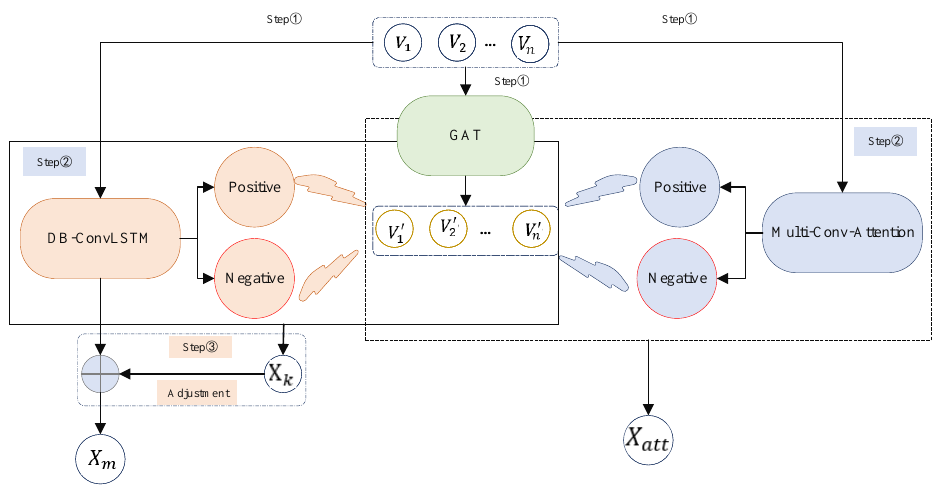
Figure 2. Step of contrastive adjustment